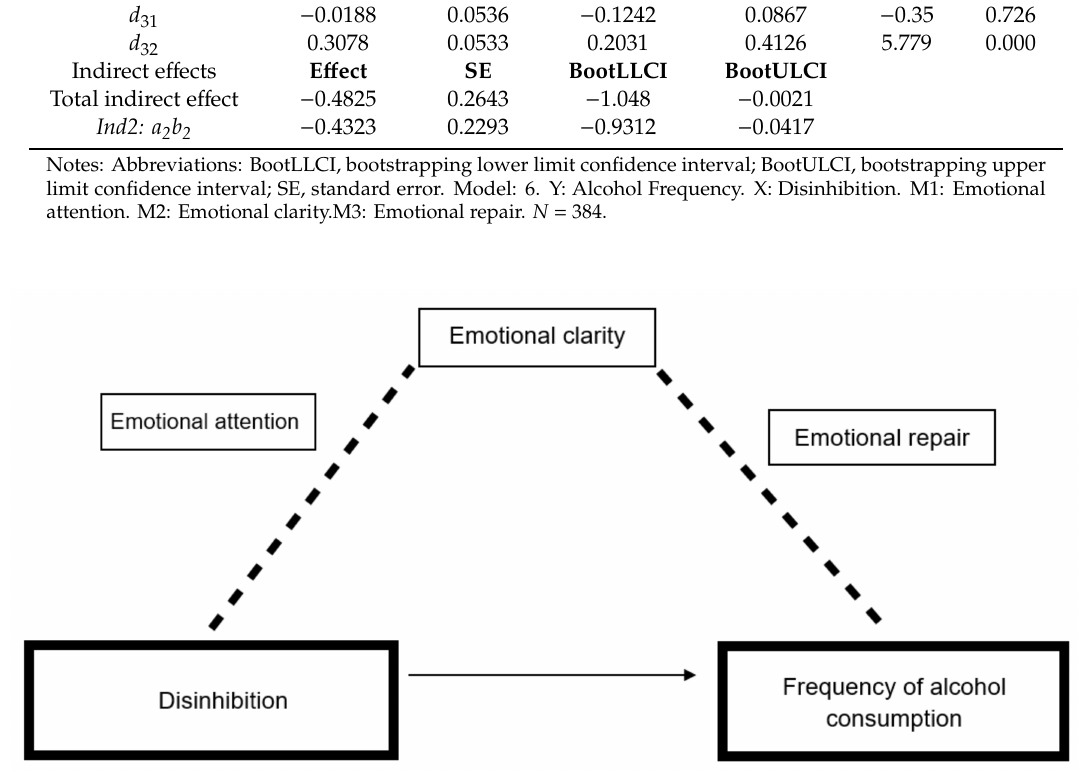
Figure 2. Illustration of mediation model between disinhibition and frequency of alcohol